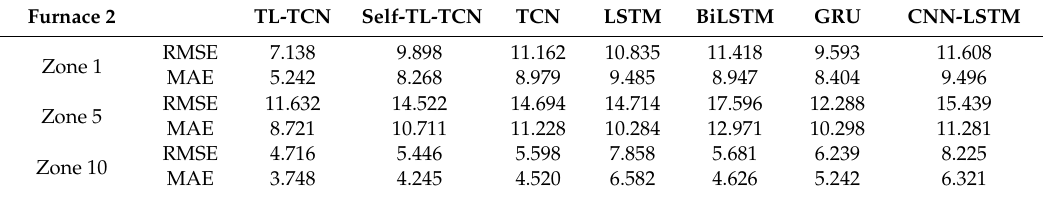
Table 19. Knowledge transfer between di ff erent equipment at di ff erent